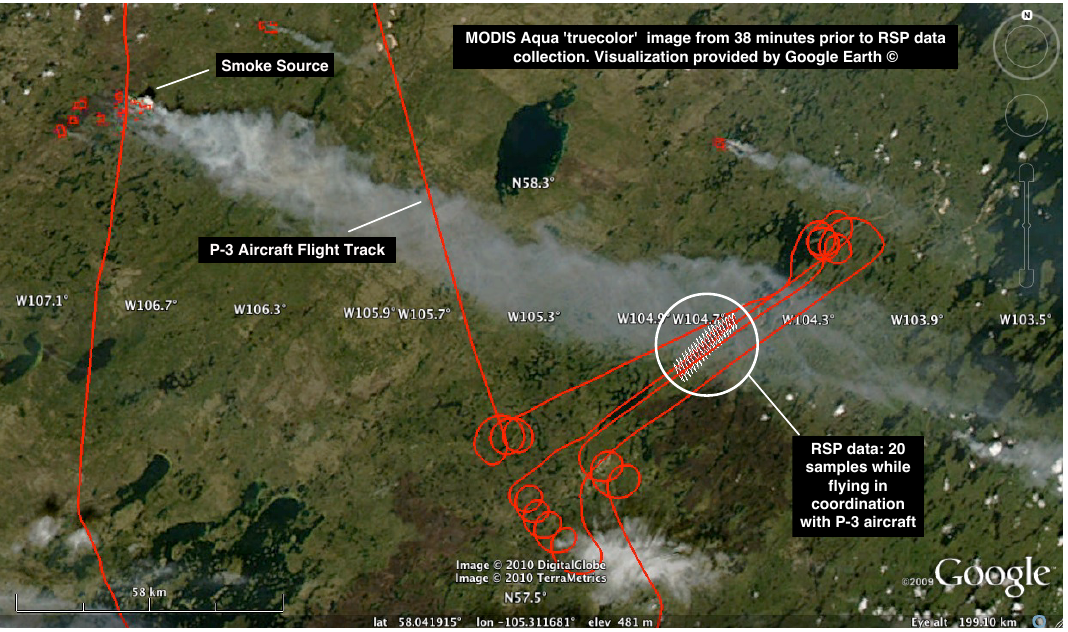
Fig. 1. MODIS Aqua satellite fire imagery from 19:50UTC. The RSP observations, indicated by the ordered white polygons at the right, were collected at 20:28UTC on the B-200 aircraft. The flight track of the P-3 aircraft is shown in red. The portion of the P-3 flight under the indicated RSP observations was coordinated to occur at the same time. Google Earth was used to visualize these